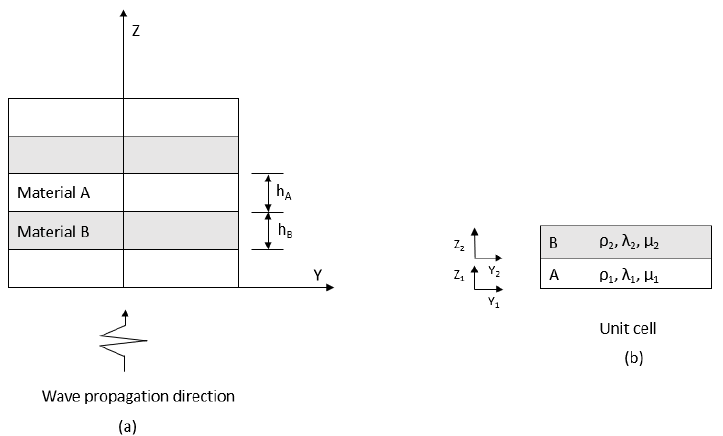
Figure 3. Visualization of the periodic material theory’s ( a ) conceptual structure and ( b ) unit cell, where index i = 1, 2 indicates layers A, B respectively, λ 1 , λ 2 , μ 1 , μ 2 denote the Lamé’s constants, p 1 , p 2 the material density and h A , h B the thickness of each layer.